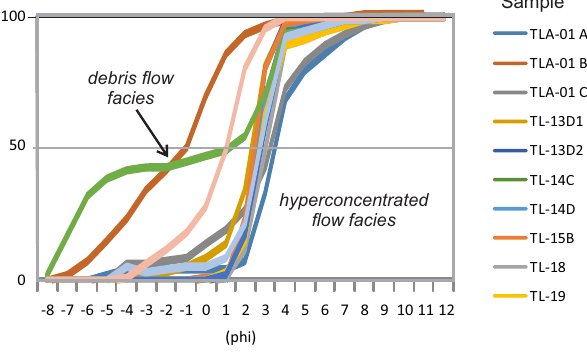
Figure 9. Cumulative curves of the TFD deposit at different dis- tances from the source. Most of the deposits are fine-grained (hy- perconcentrated flow deposits), while a few exposures contained boulder- and gravel-sized particles set in a silty matrix (debris flow deposits). See Fig. 8 for locations of samples.